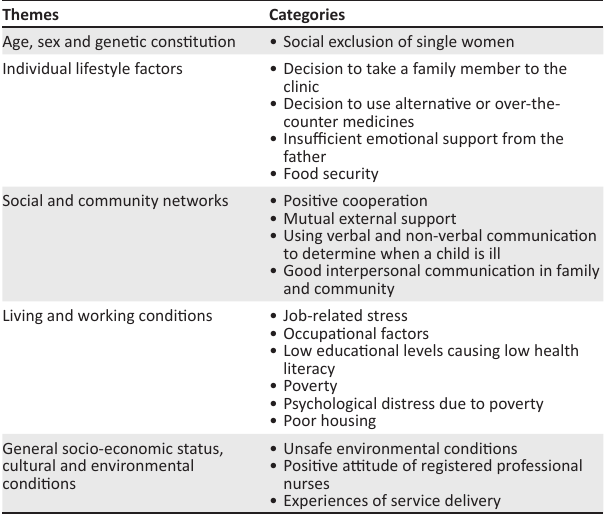
TABLE 1: Thematic themes and categories generated from the